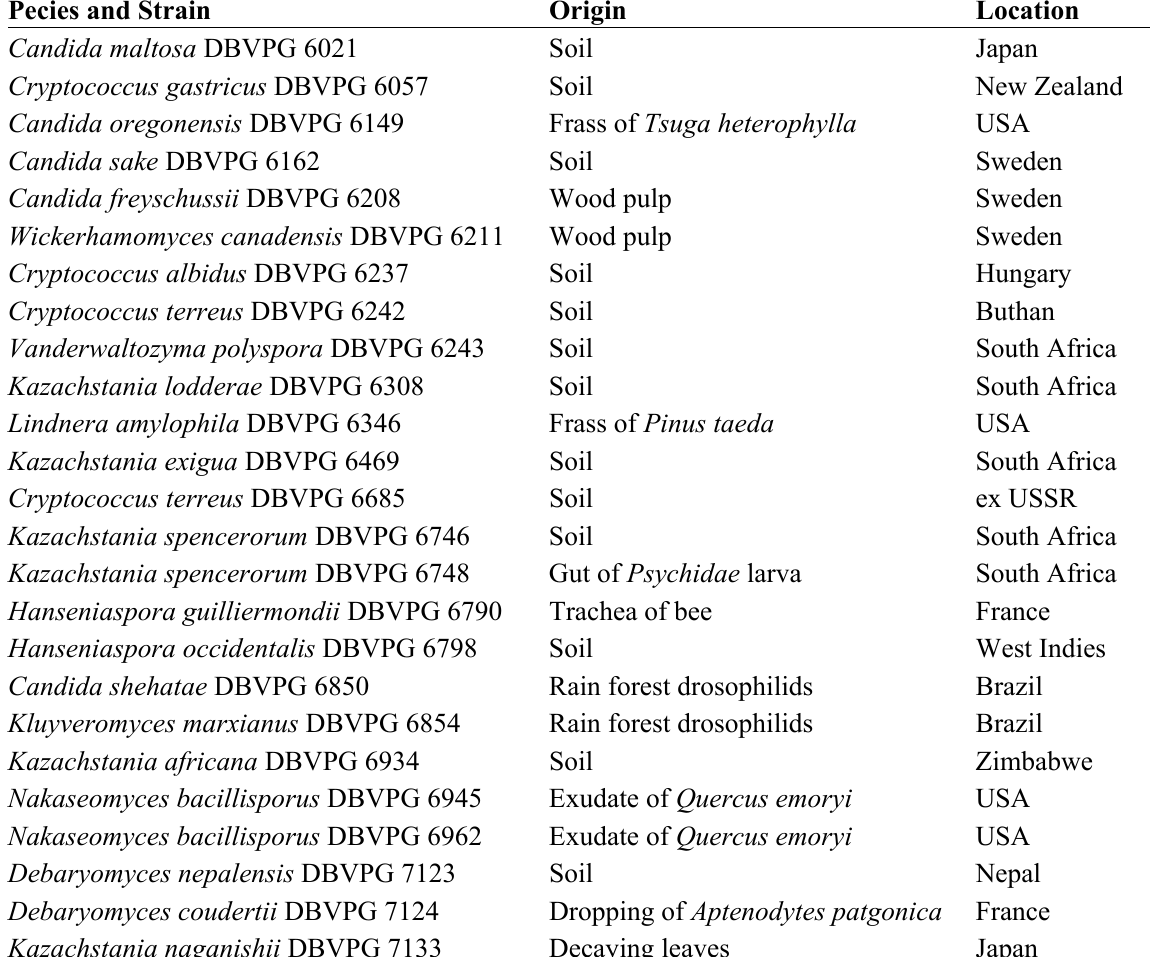
Table 3. Salient information on NCY strains used in the present